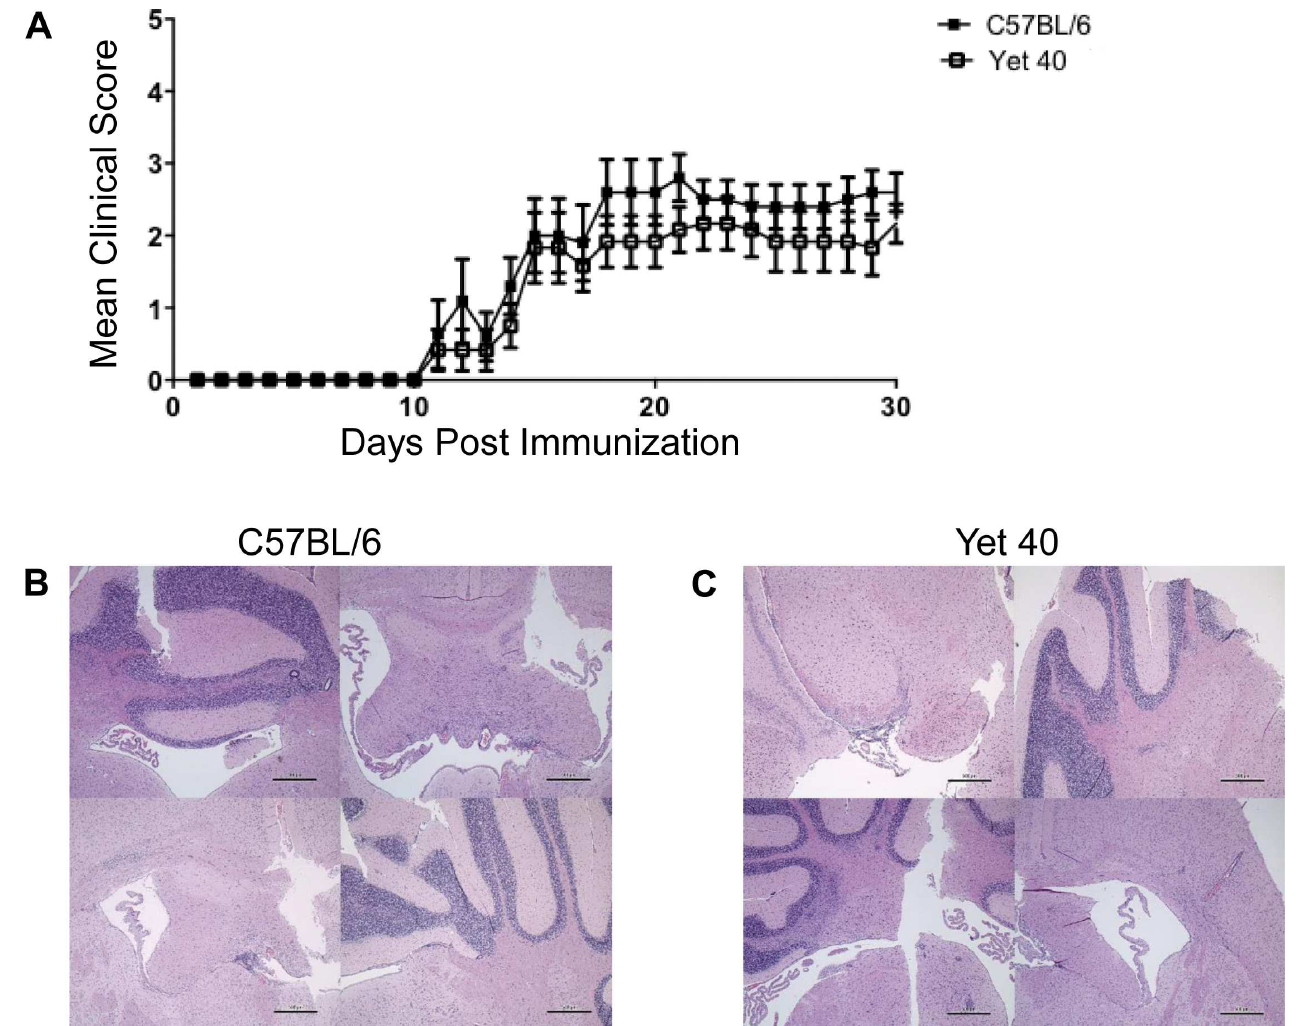
Fig 1. Yet40 mice are susceptible to experimental autoimmune encephalitis (EAE). (A) To identify APC populationsthat express IL12/23 p40 in vivo during EAE, and that are potentially capableof initiatingand perpetuatingCNS inflammation,B6.129-Il12bstrain of p40eYFP reporter mice (yet40 mice) were actively immunized with CFA/MOG p35-55 . The onset of disease and the clinical disease course were similar in both experimental groups (please see the Material and Methods section for definitionsof disease stages). Mean clinical scores of yet40 mice were less severe than those observed in C57BL/6 mice, althoughthose differences were not significant. (B & C) There was no difference in the number of inflammatory cellular infiltrates between yet40 mice and C57BL/6 wild-typemice in the CNS. Representative sections of brain tissue are shown.